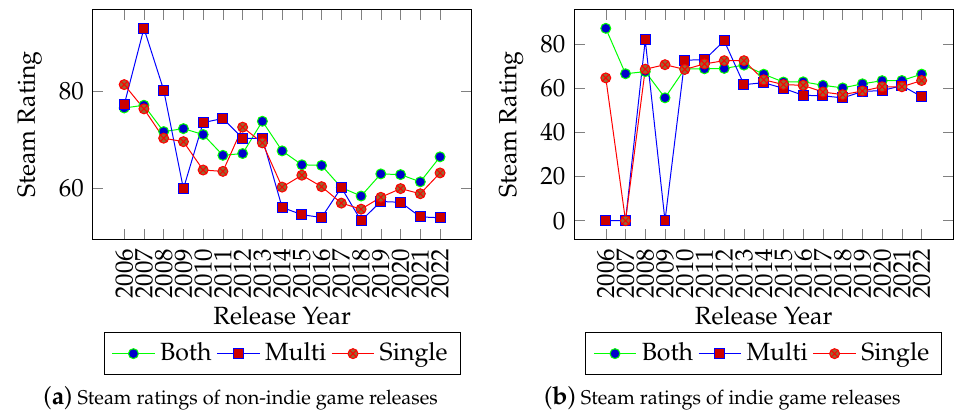
Figure 8. Steam ratings of game types released over the year for ( a ) non-indie games and ( b ) in- die games.